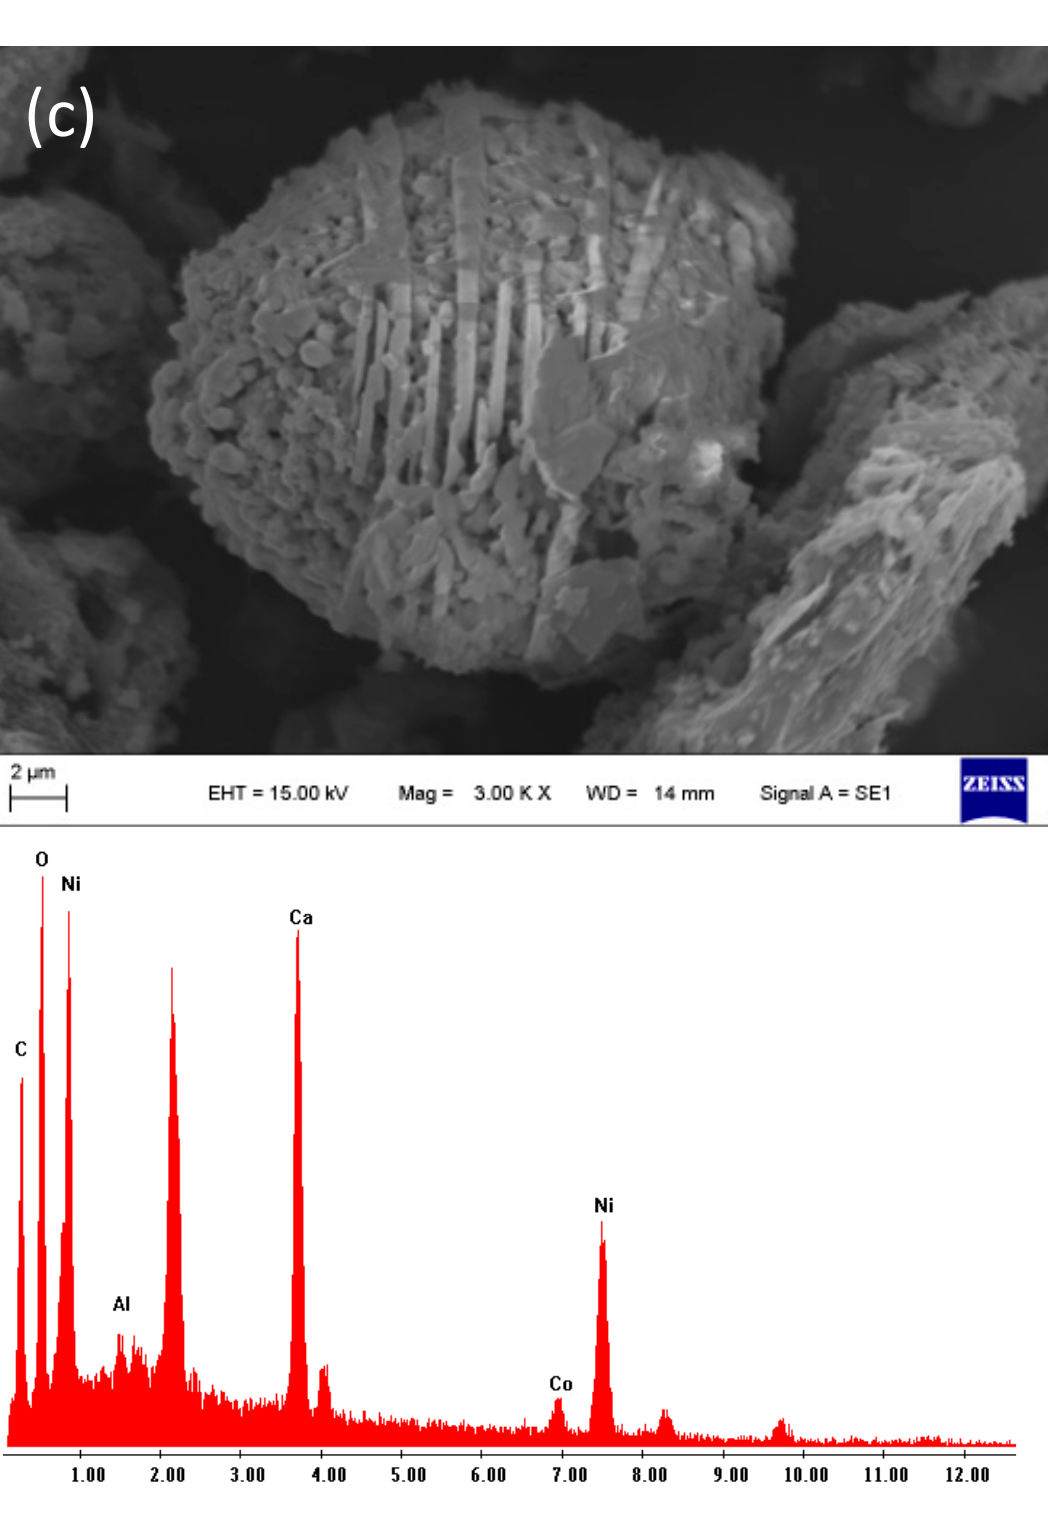
Figure 5. SEM micrographs and EDS spectra of NSP samples from the calcination of BM/CaCl 2 /CB at 700 °C. ( a ) SBM, ( b ) VBM-1, and ( c ) VBM-2.